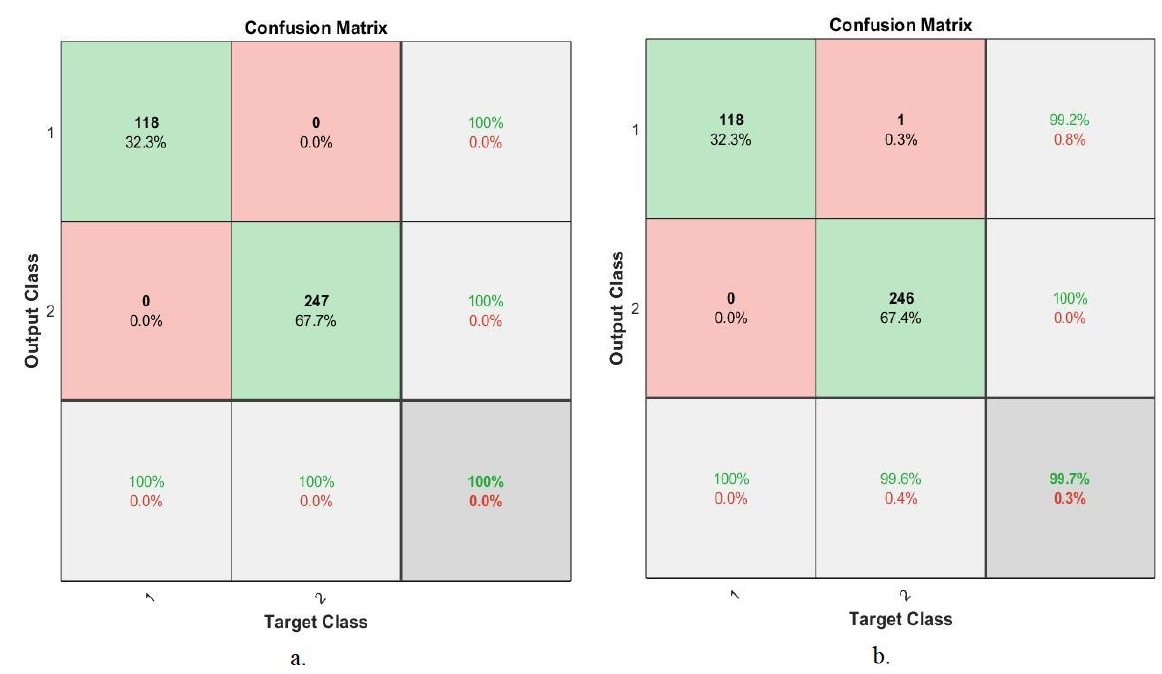
Figure 14. Confusion matrix for ANN for classifying a 400× dataset based on fusion features by ( a ) AlexNet with FCH, LBP, and GLCM and by ( b ) GoogLeNet with FCH, LBP, and GLCM.